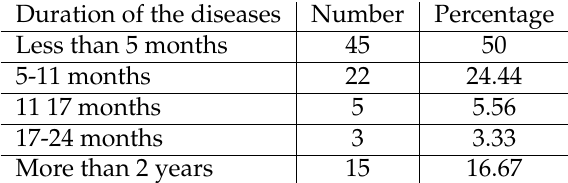
Table 2. Duration of the